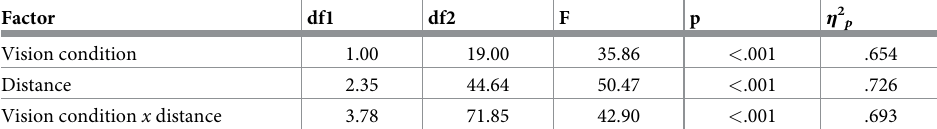
Table 6. Results of the two-factor ANOVA with repeated measures (6 distances; 2 vision conditions) for the pre- dicted putting distance. Corrected by Greenhouse-Geisser � . Factor df1 df2 F p η 2 p Vision condition 1.00 19.00 35.86 < .001 .654 Distance 2.35 44.64 50.47 < .001 .726 Vision condition x distance 3.78 71.85 42.90